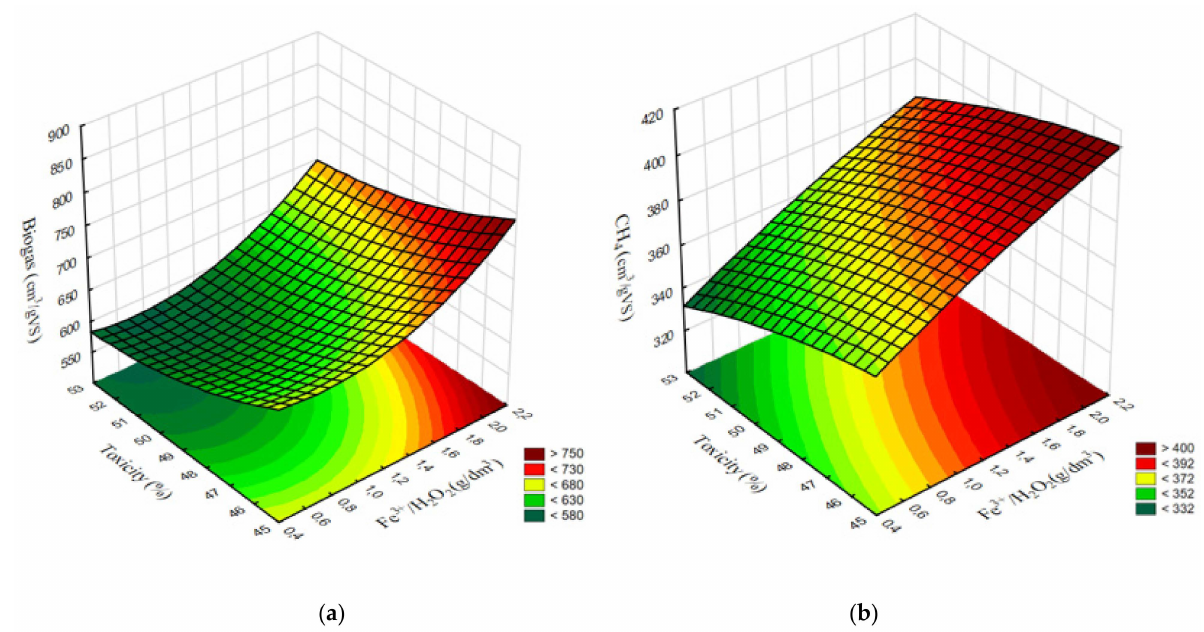
Figure 14. Predicted surface correlation between Fenton’s reagent dosage + toxicity and production of ( a ) biogas and ( b ) methane in series